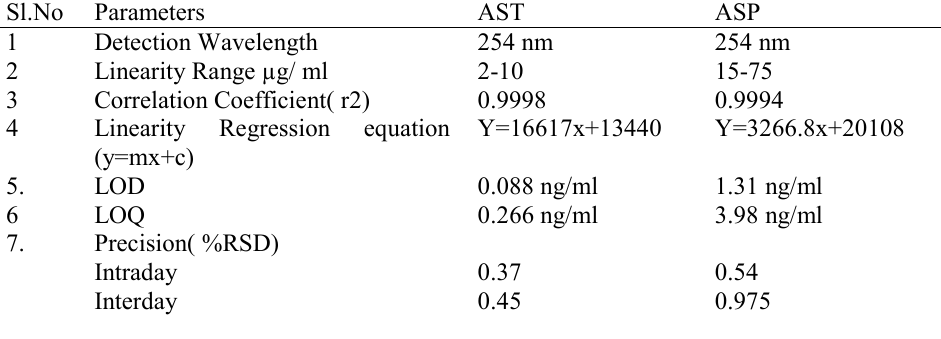
Table 2. Linear regression data of AST and NA.